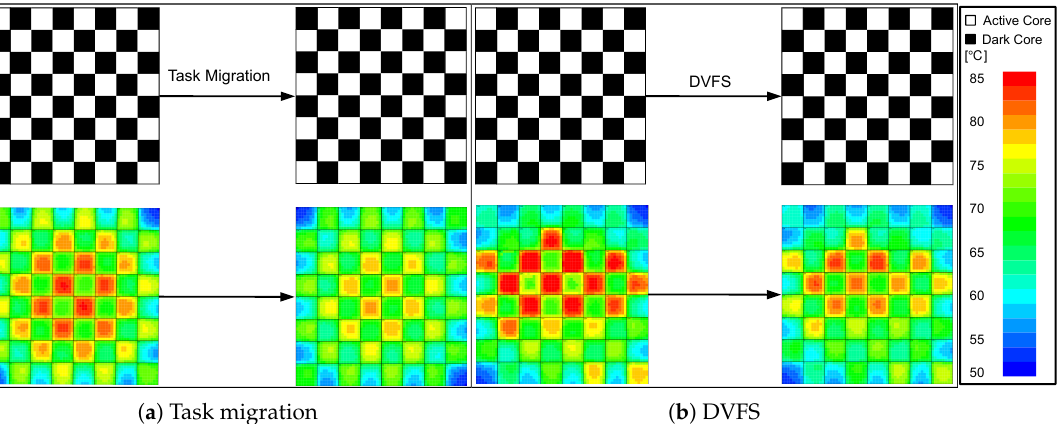
Figure 2. DTaPO technique: ( a ) perform task migration; and ( b ) perform